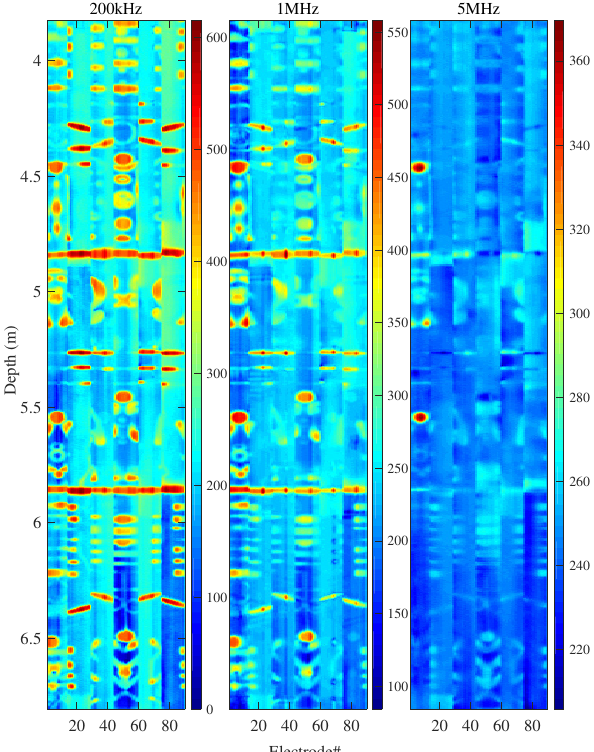
Figure 13. The imaging result of borehole wall patterns with UMMAI sample modulus in the second test, while the borehole is filled with water-based mud.